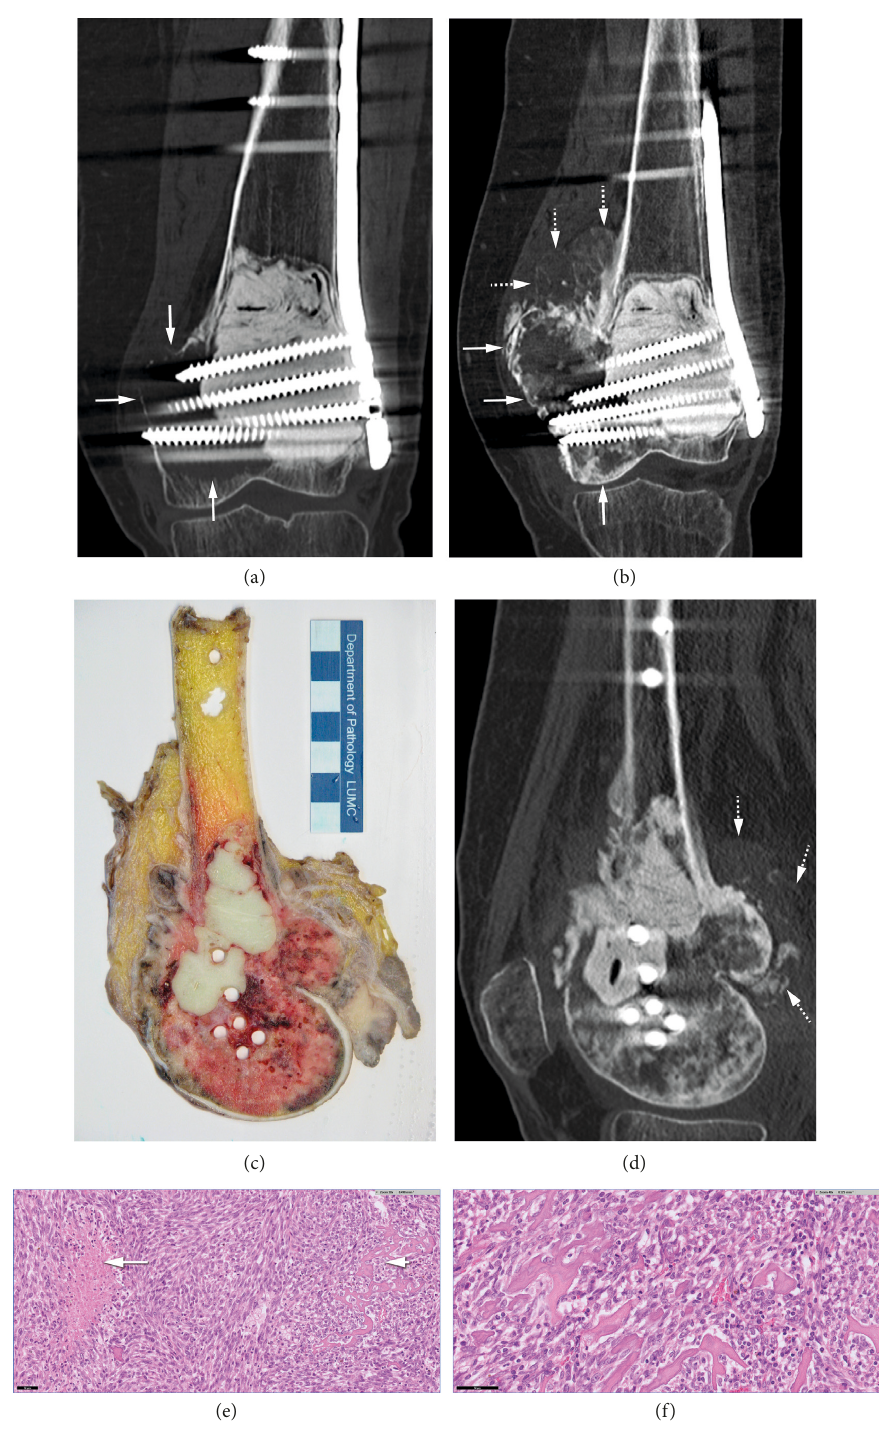
Figure 3: Case 3, same case as in Figure 2; local recurrence occurred 1 year after curettage, followed by denosumab treatment. After en bloc resection, the diagnosis of malignant GCTB was made. (a) Coronal CT image performed for follow-up approximately 1 year after surgery showed osteolysis along the medial bone-cement interface (arrows) in keeping with local recurrence. Denosumab treatment was started after this scan. (b) Coronal CTimage after 10 months of denosumab therapy showed increased density in the osteolytic area of recurrence due to formation of fibro-osseous tissue (vertical arrow at the medial femoral condyle), the tumor expanded further into the soft tissues with an irregular margin (horizontal arrows). In addition, proximal to the area of local recurrence there was a newly formed component of osteoid matrix (dotted arrows), suspicious for progression to osteosarcoma. (c) Photograph of tumor macroscopy (sagittal section) after en bloc resection shows the cementum from the previous surgery, surrounded by tumor tissue extending into the soft tissue. (d) Sagittal CT reformatted after the macroscopy section (Figure 3(c)) shows endomedullary cement and holes due to previous screw tracts, surrounded by denosumab changes (asterisk). Posterior soft tissue mass is noted with osteoid matrix formation suspicious for an osteosarcoma (dotted arrows). (e) Histology at the time of resection; low power view displaying highly cellular spindle cell proliferation with areas of tumor necrosis (left) and the formation of tumor osteoid (right). Scale bar of 50 μ m. (f) Tumor osteoid in high-power field fitting with the histological features of an osteosarcoma. Scale bar 50 μ